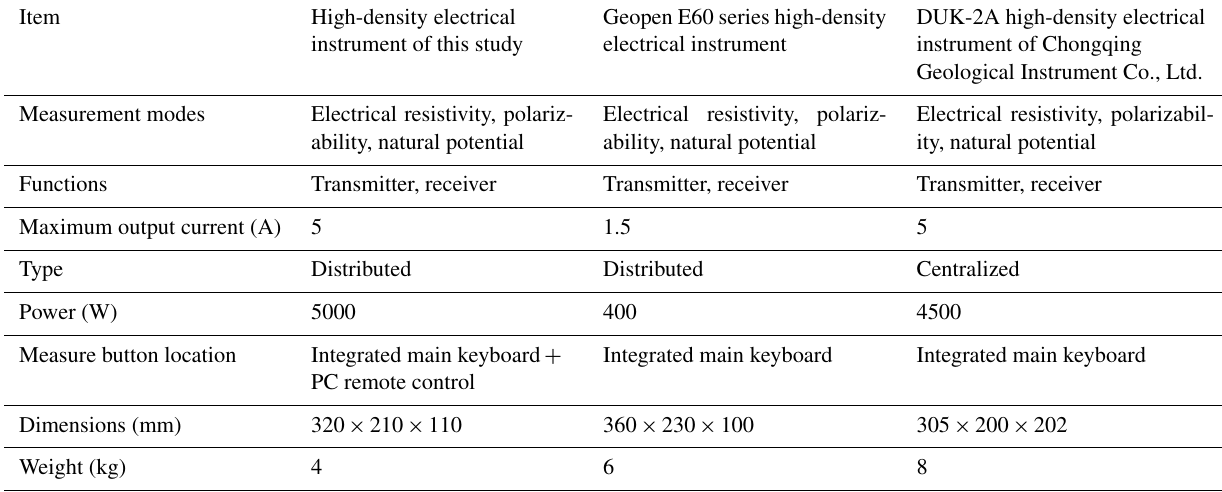
Geological Instrument Co.,